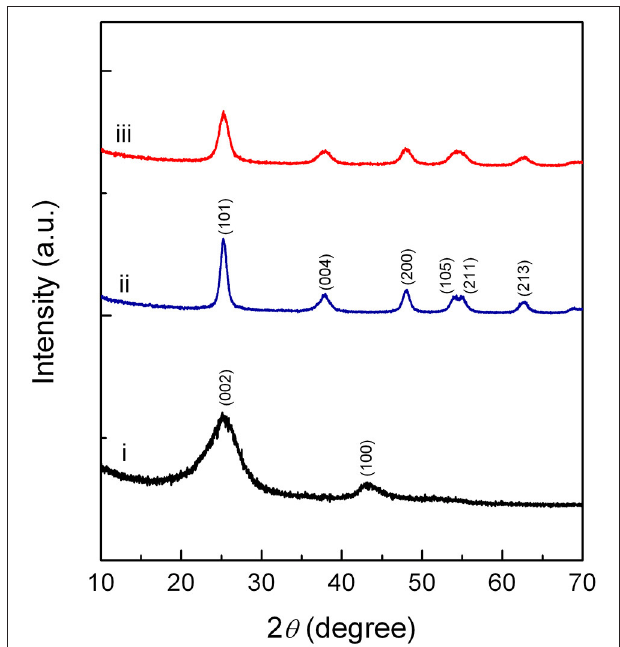
FIGURE 1 | X-ray diffraction patterns of neat CNT (i), Pd-Cu/TiO 2 (ii), and Pd-Cu/20CNT-TiO 2